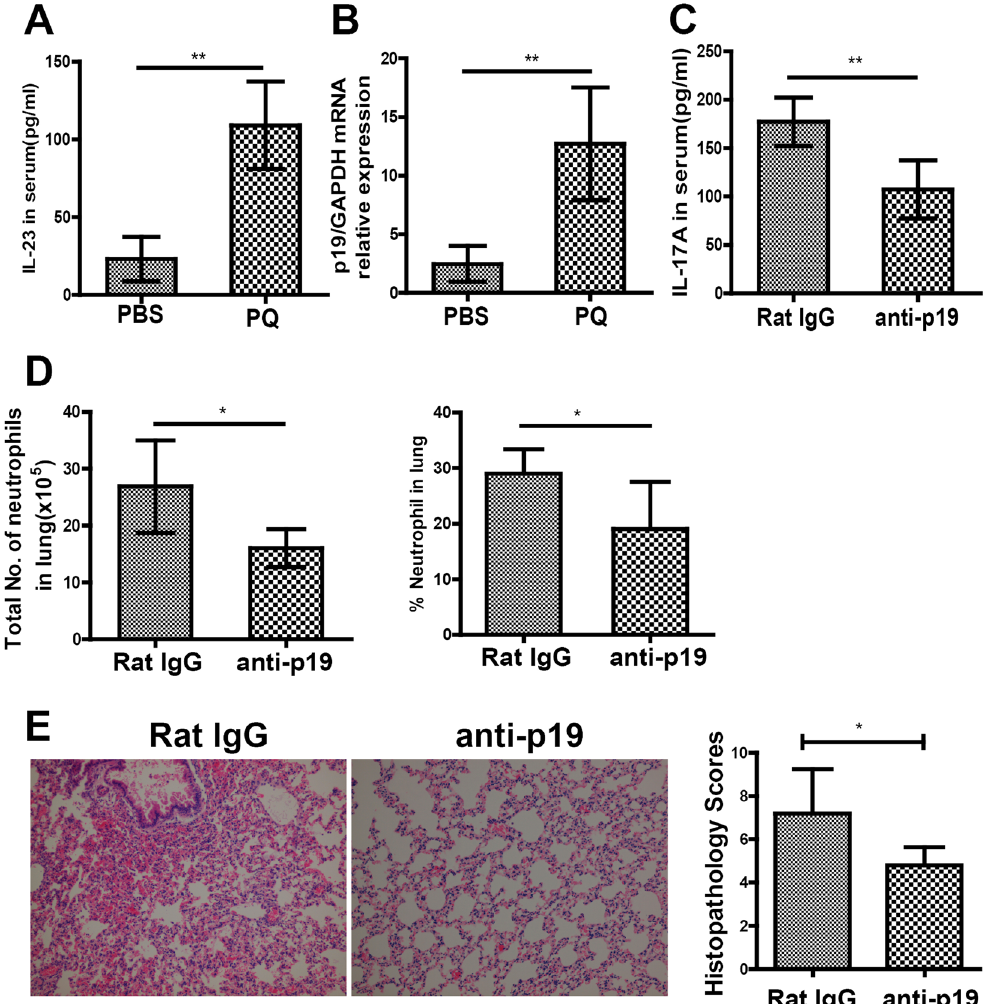
Figure 4. IL-23 is essential for the production of IL-17A and neutrophil infiltration into the lung in response to PQ challenge. ( A , B ) At 72 h after PQ or PBS gavage, the serum IL-23 level as measured by ELISA ( A ), and the steady-state mRNA level of IL-23 in the lung tissue detected by RT-PCR ( B ) were significantly higher in PQ group than in PBS group. Mice were intravenously injected with either neutralizing antibody for IL-2319p (anti- 19p; n = 6) or isotype-matched control IgG (rat IgG; n = 6) at one hour before they received PQ gavage. At 72 h after PQ challenge, the mice were sacrificed, and serum and lung tissues were collected. ( C , D ) Pre-treatment with anti-19p significantly reduced serum IL-17A level ( C ), the No. and percentage of lung-infiltrating neutrophils ( D ), and significantly decreased histopathology score of the lung tissue ( E ) than in mice pre-treated with control rat IgG. All data were presented as mean ± SD for all mice in each group and compared between the PQ- and PBS-challenged mice (A and B) or between the anti-19p- and rat IgG-injected mice (C, D, and E). * P < 0.05 and ** P <